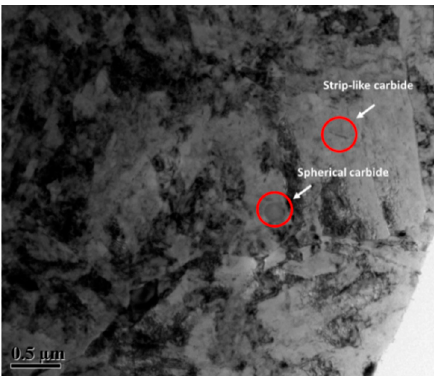
Figure 8. TEM images showing different kinds of precipitates of 25Cr3Mo2NiWVNb steel after tempering at 640 °C. ( a ) M 2 C; ( b ) M 6 C; ( c ) MC; ( d ) the corresponding diffraction pattern of MC.